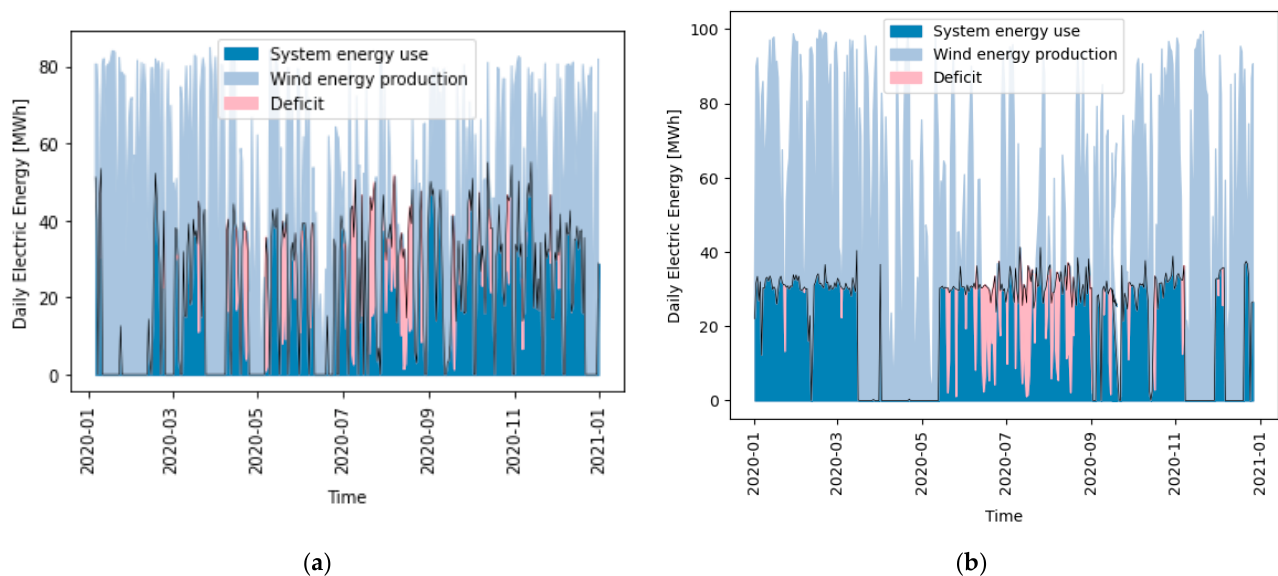
Figure A2. Hydrogen fuel system energy use and wind energy generation under the parameter set of Appendix A, Table A3, for the ( a ) Earl Thorfinn and ( b ) Frisia III.